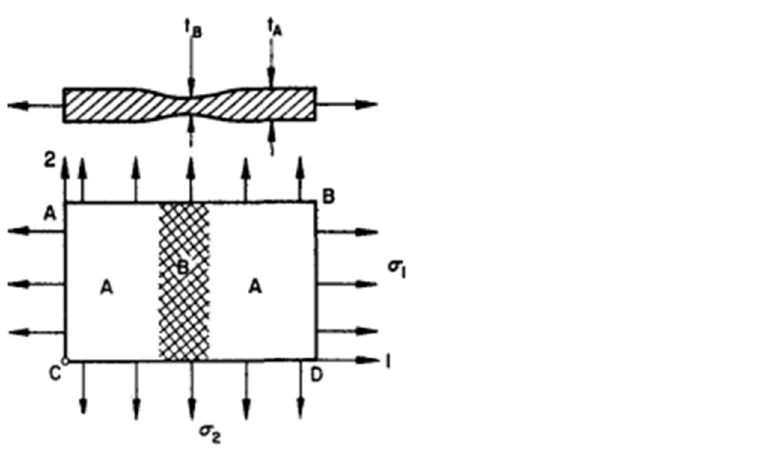
Figure 31. A schematic description of the pre-existing groove supposed in the M-K model before the deformation. Reprinted from Ref. [321] with permission. Copyright 1967, Elsevier.